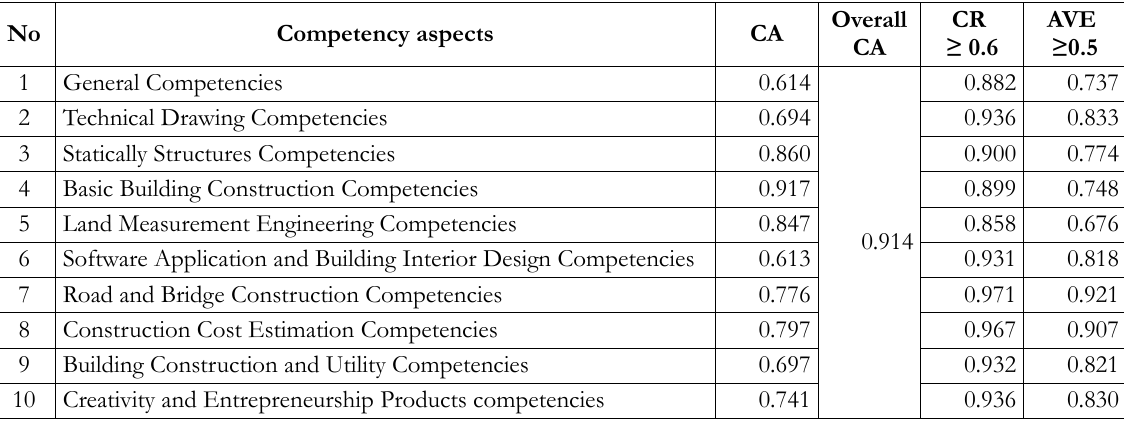
Table 3. Reliability analysis of competency